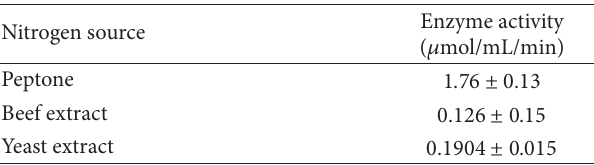
Table 4: L-asparaginase production by Streptomyces ginsengisoli grown in asparagine dextrose salt broth amended with different nitrogen sources.